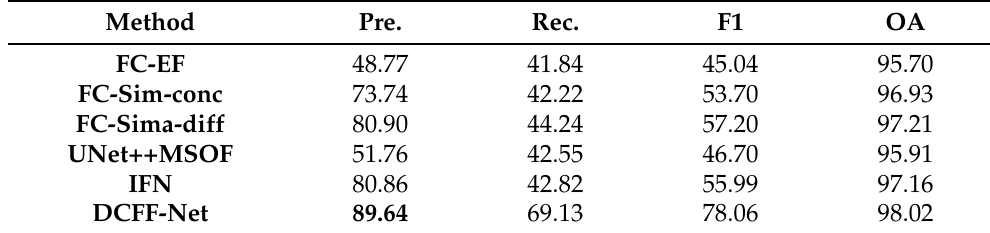
Table 4. Evaluation results of TRCD and other advanced algorithms on LEVIR-CD with 4096 pairs of images.